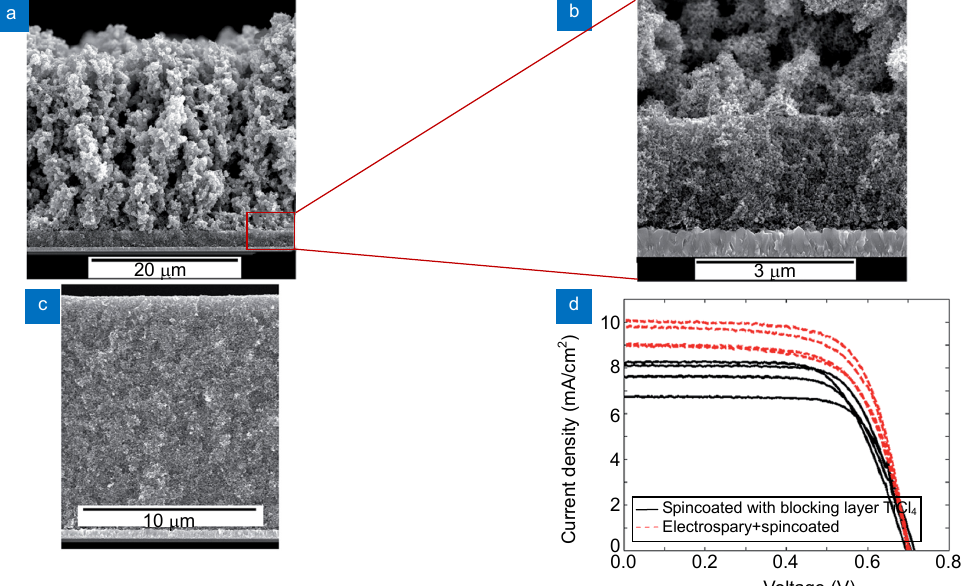
Fig. 15 | Comparison of a hybrid electrospray and spin coated DSSC with bilayer structure with a purely spin coated one 37 . (a) SEM image of hybrid structure with close up of the interface in (b) . (c) SEM cross section of a spin coated (5×) DSSC. (d) J – V characteristics comparing the two structures (with the spin coated cell having TiO 2 blocking layers and TiCl 4 treatment).